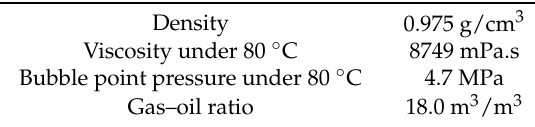
Table 1. Properties of the experiment of live oil.